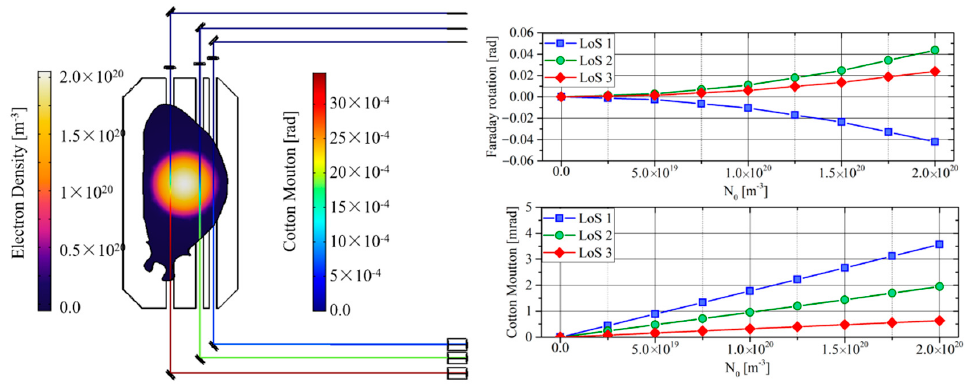
Figure 5. Polarimeter